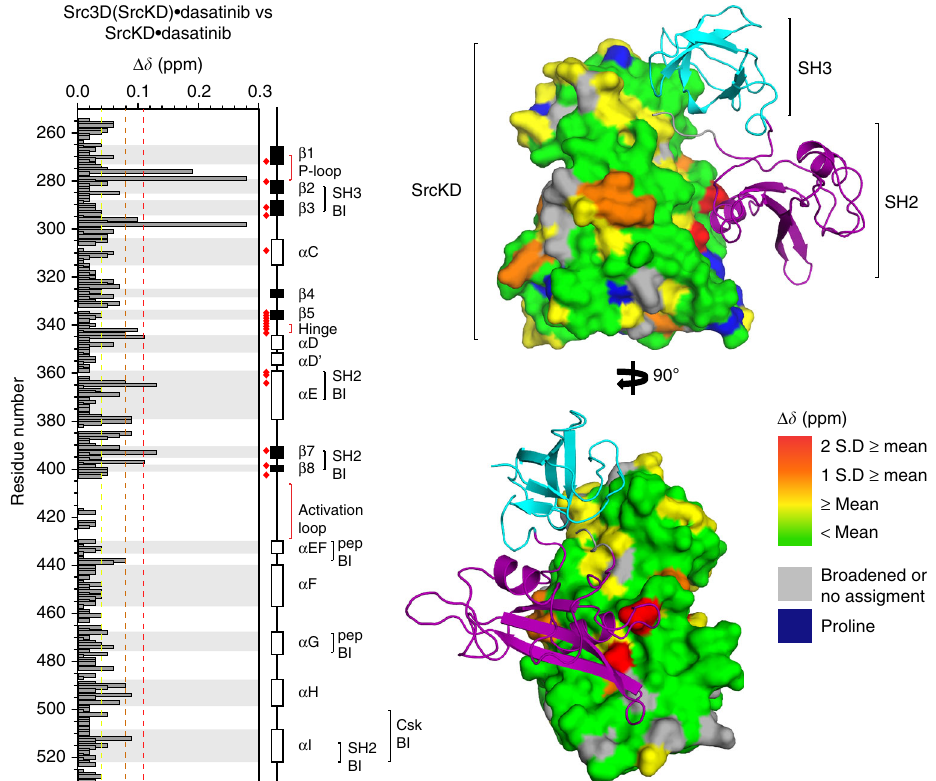
Fig. 8 The SH3 – SH2 domains interact with the dasatinib stabilized kinase domain of a Src3D fusion construct. Histogram and structure mapping analysis of CSPs between isolated SrcKD (cid:129) dasatinib and SrcKD (cid:129) dasatinib from Src3D fusion (cid:129) dasatinib, suggest an interaction between the regulatory domains and the kinase domain in the context of Src3D fusion (cid:129) dasatinib. The CSPs were mapped to the structure of SrcKD (cid:129) dasatinib (PDB: 3G5D) with the regulatory SH3 – SH2 domains from near full length Src (PDB: 2SRC PDB) superimposed, indicating that they interact with the SH3 and SH2-binding interfaces. As shown in the histogram the SH3-binding interface comprises of the SH2-SrcKD linker, β 2- β 3 loop, the SH2-binding site comprises of: helix-E, β 7- β 8 loop, helix- α I, and the carboxy-terminal